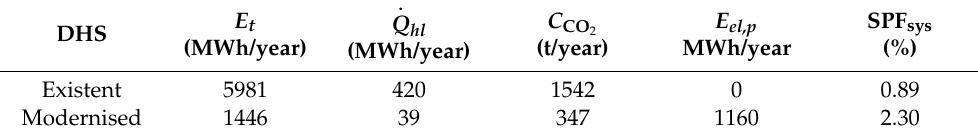
Table 7. The main results of numerical simulation.